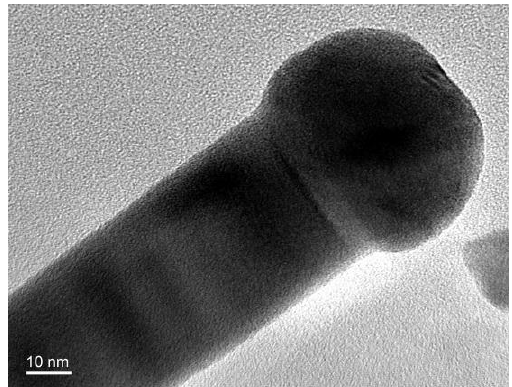
Figure 3. TEM micrograph of a single ITO crystal rod.